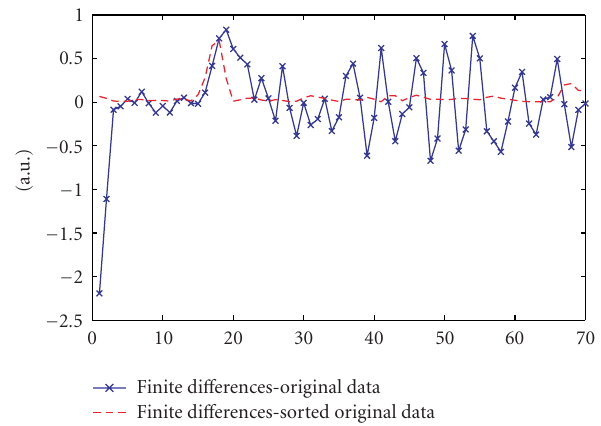
Figure 2: Comparison of sparsity of the fully sampled original nonsmooth signal in Figure 1(b) and that of the corresponding sorted signal in terms of finite di ff